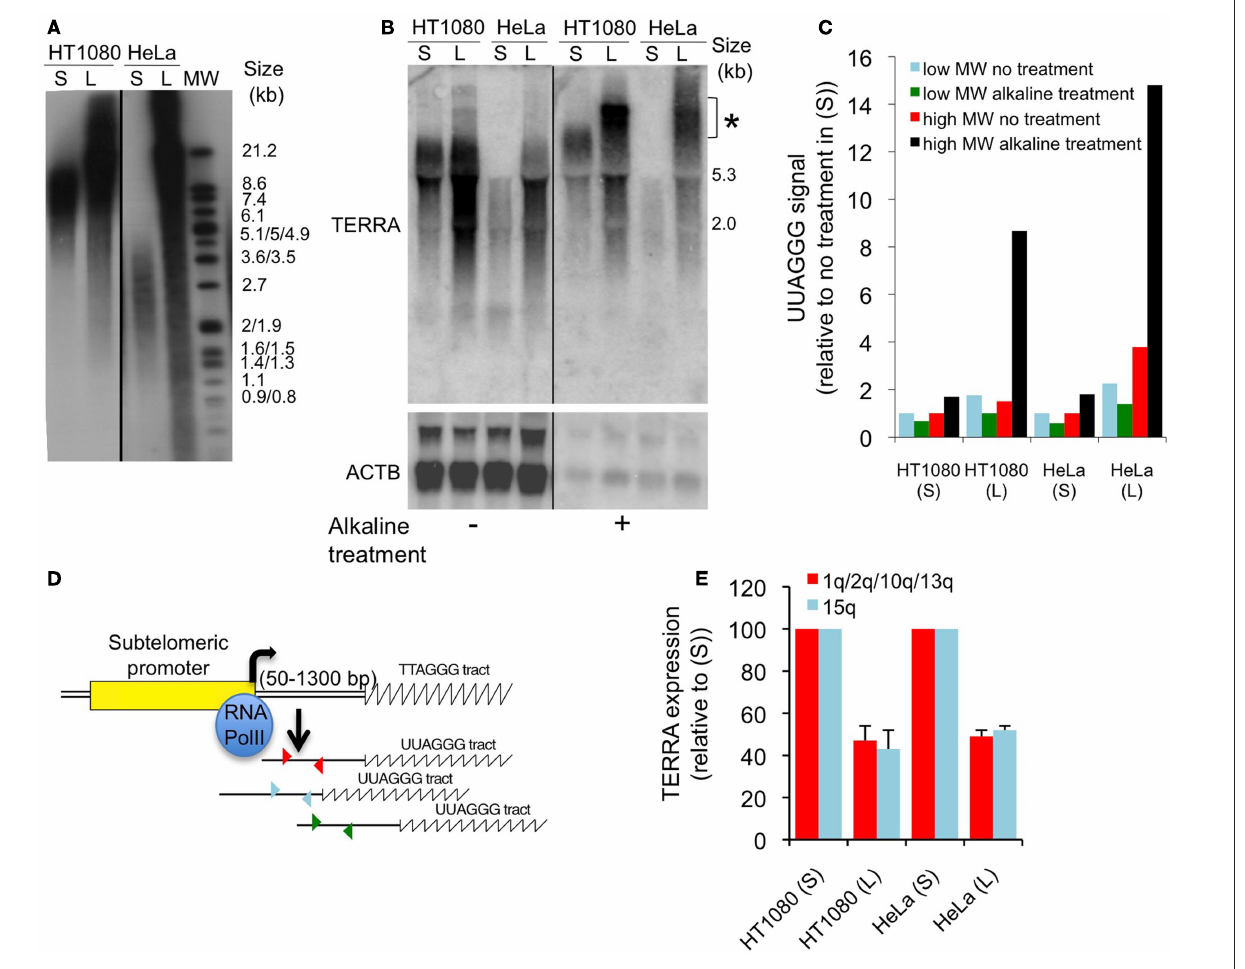
(B) . (D) Cartoon representing human chromosome ends and subtelomeric primers (arrowheads) that are used to quantify TERRA molecules from various chromosome ends by qRT-PCR. (e) qRT-PCR analyses of TERRA molecules transcribed from either 1q/2q/10q/13q or 15q in the four cell lines described in (A) . Values were normalized to parental cell lines and error bars represent SD. All methods used here have been described in Arnoult et al.